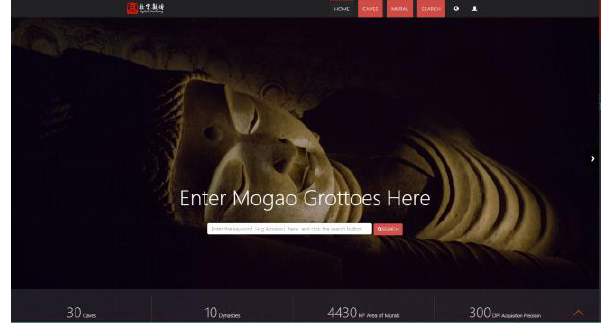
Figure 1 . Digital Dunhuang resource database